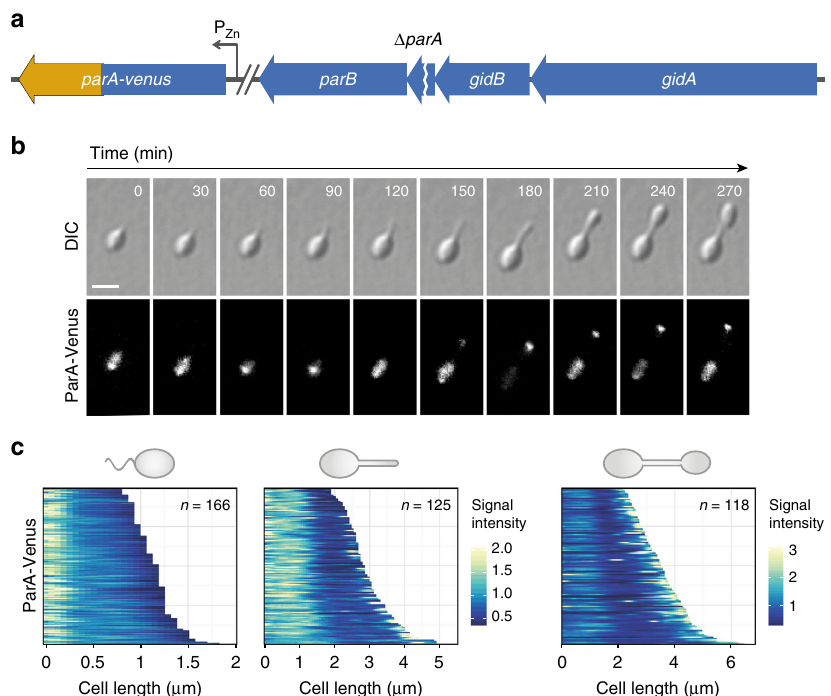
Fig. 3 Localization dynamics of ParA. a Schematic explaining the construction of the strain used to follow the localization of ParA (AJ46). b Time-lapse series showing the localization of ParA-Venus at different stages of the cell cycle. Cells of strain AJ46 ( Δ parA P Zn ::P Zn - parA-venus ) were grown in MB medium supplemented with 0.3 mM ZnSO 4 , transferred to an MB-agarose pad containing 0.3 mM ZnSO 4 , and imaged at 30 min intervals by DIC and fl uorescence microscopy. Bar: 3 µ m. c Demographic analysis of ParA-Venus localization in swarmer (left), stalked (middle), and budding (right) cells. Cells of strain AJ46 were grown in MB medium containing 0.3 mM ZnSO 4 and analyzed by DIC and fl uorescence microscopy. The fl uorescence intensity pro fi les obtained for each cell type were then sorted according to cell length and stacked on top of each